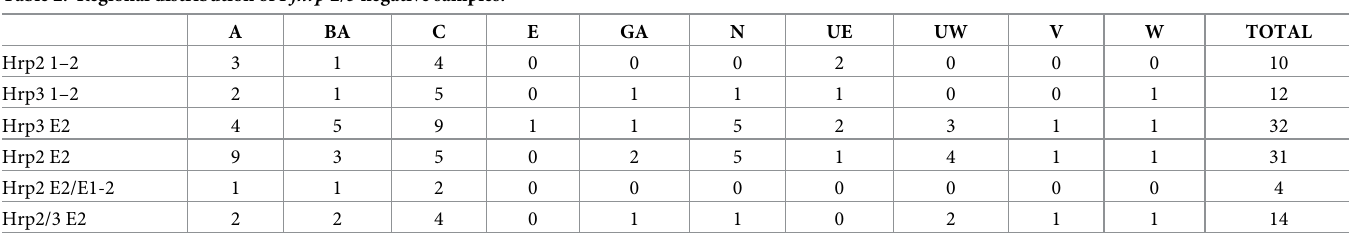
Table 2. Regional distribution of Pfhrp 2/3 negative samples.